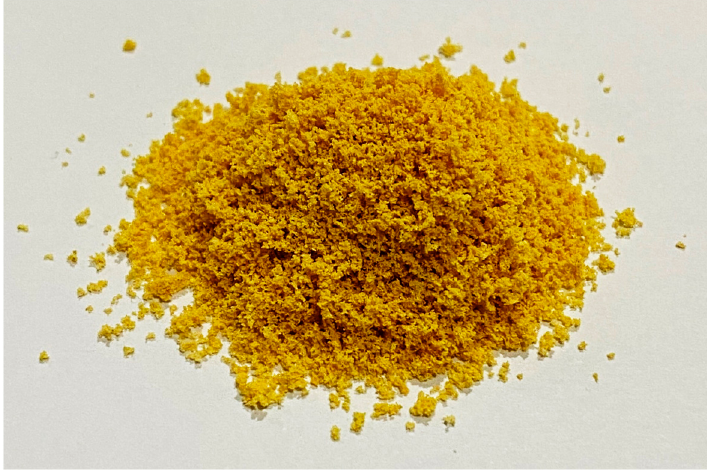
Figure 2. Mangosteen peel extract